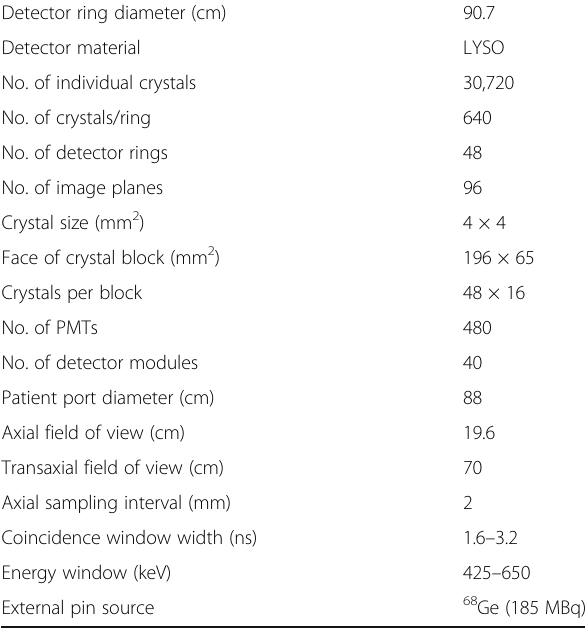
Table 2 Celesteion: major PET technical